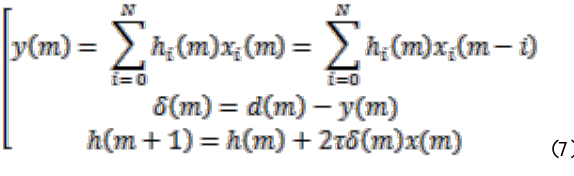
Figure 4.3and figure 4.4 is the time and frequency domain amplitude field data. We can come to the conclusion that the noise is filtered out effectively, leaving the signal of interest in figure 4.5 and figure 4.6. i.e., the anomaly